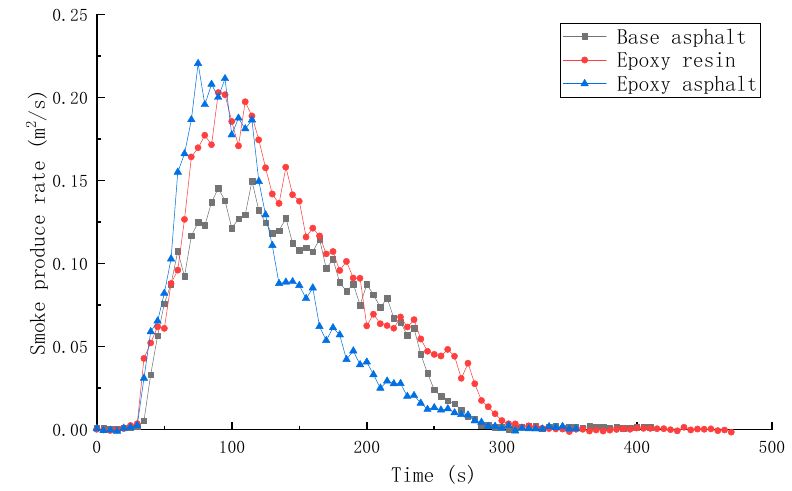
Figure 9. SPR of different materials.